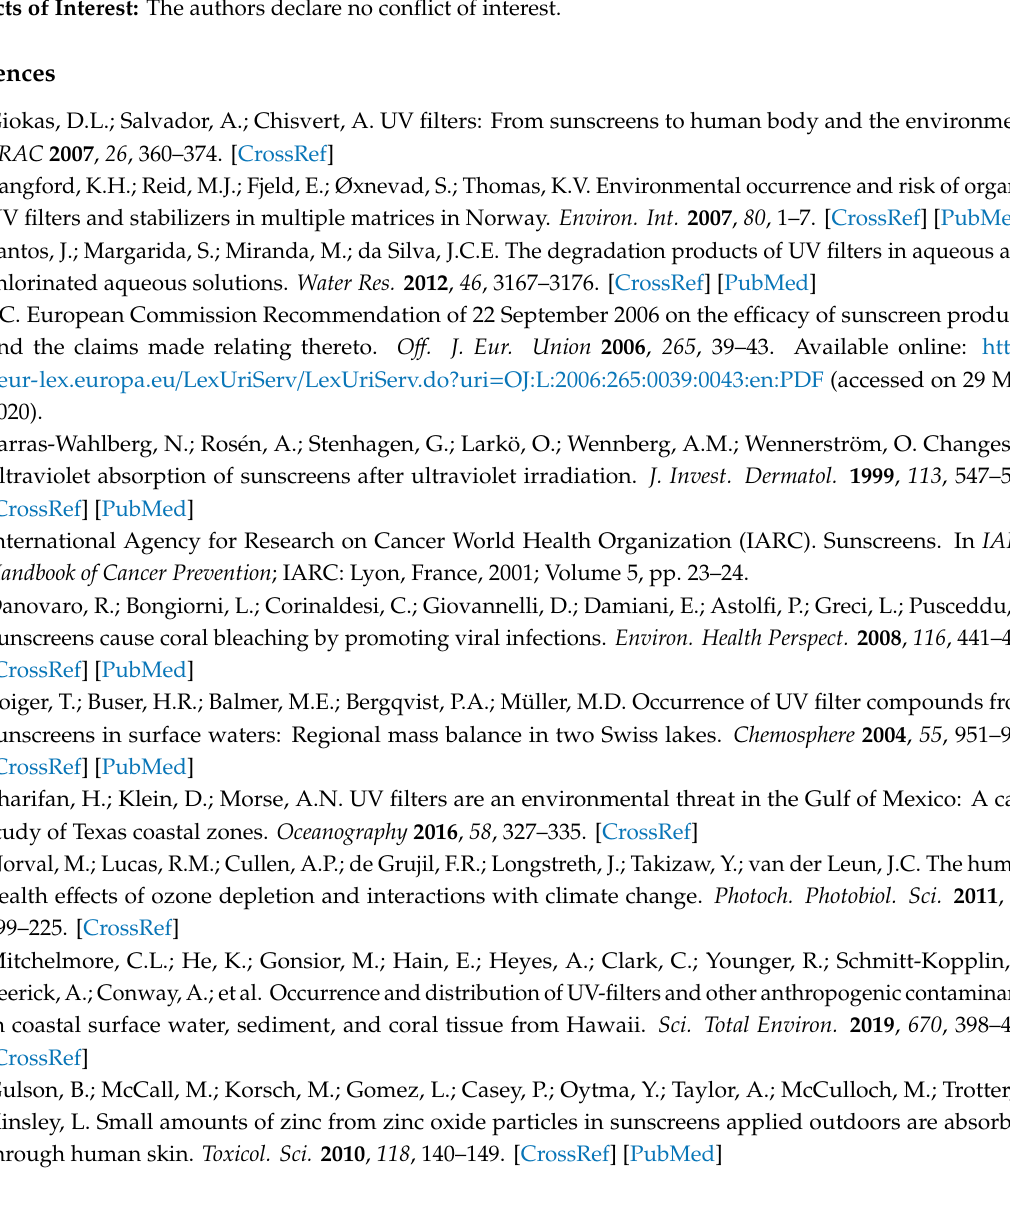
Table S1: An occurrence of the selected UV-filters in organisms living in marine and freshwater habitats (d.w.—dry weight, l.w.—lipid weight, n.d.—not detected, OD-PABA—2-ethylhexyl 4-(dimethyloamino) benzoate, BP-4—benzophenone-4, IMC—3-methylbutyl-(2E)-3-(4-methoxyphenyl)-acrylate) [61–66], Table S2: